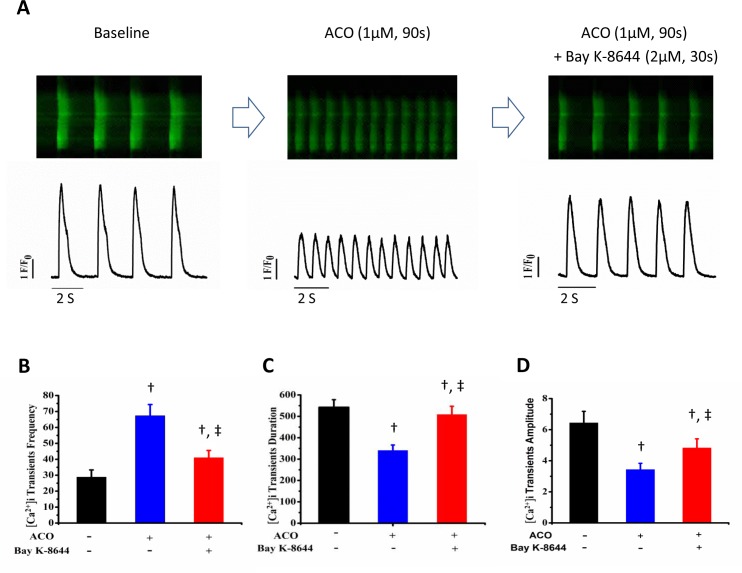
Effects of ACO on [Ca2+]i transients in hiPSC-CMs.(A) Representative traces of the [Ca2+]i transients recorded in a hiPSC-CM at baseline and with subsequent exposure of ACO and ACO plus Bay K-8644. (B, C, and D) Bar-graphs show the changes in [Ca2+]i transient frequency, duration and amplitude in hiPSC-CMs. †p < 0.01, vs. baseline. ‡
p < 0.001, vs. ACO. n = 7.